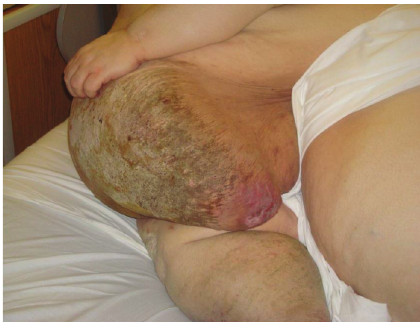
Figure 1: Case 1.